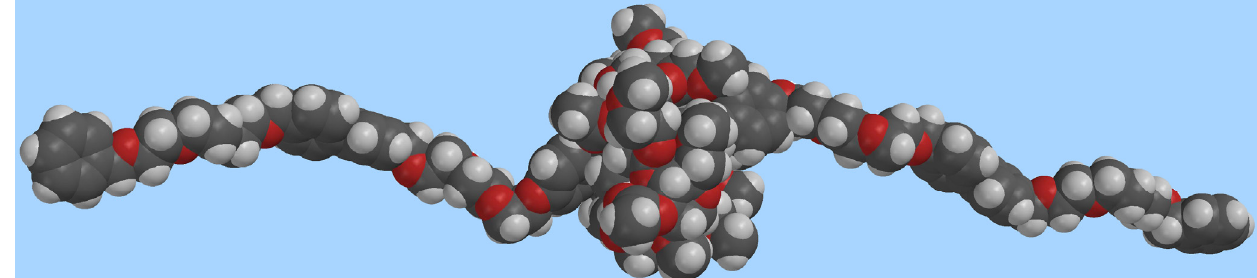
Figure 3 . Space-filling molecular model of the [2]pseudorotaxane 1 ⊃ 2 ⋅ 2Cl (grey: carbon, white: hydrogen, red: oxygen; chloride ions omitted for